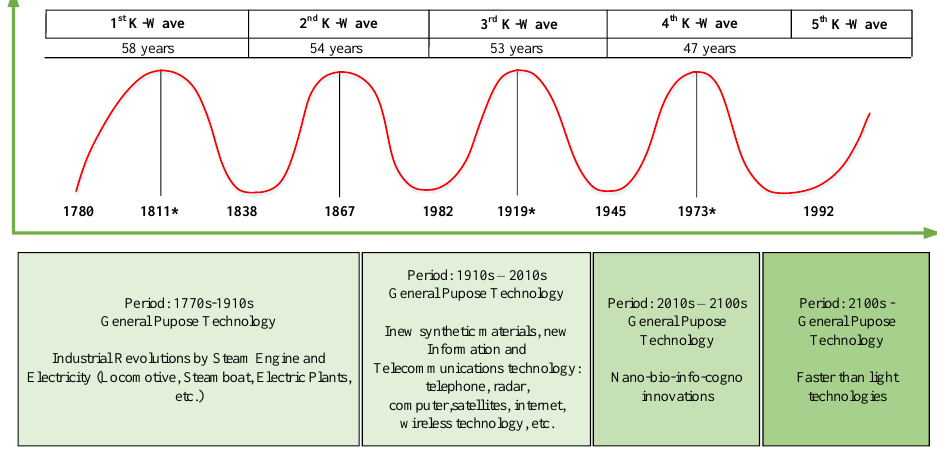
Fig. 2. Evolution of technologies for the dynamics of K-waves [24].